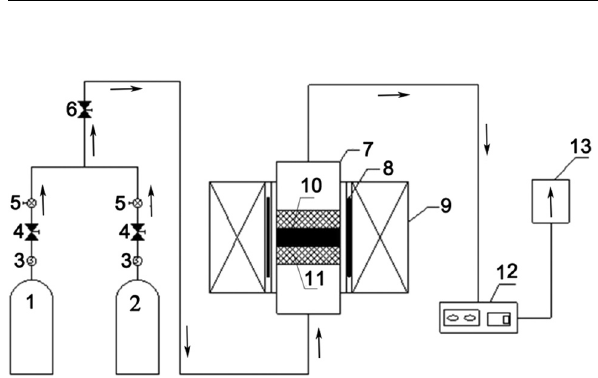
Figure 1: Experimental setup for the catalytic oxidation of methane. ( 1 ) N ( 2 ) O ( 3 ) pressure 2 /CH 4 mixed gas cylinders; 2 gas cylinders; gauge; ( 4 ) pressure - reducing valve; ( 5 ) mass fl ow meter; ( 6 ) reaction valve; ( 7 ) quartz tube; ( 8 ) thermocouple; ( 9 ) furnace wall; ( 10 ) catalyst; ( 11 ) quartz cotton; ( 12 ) gas chromatograph; ( 13 ) exhaust